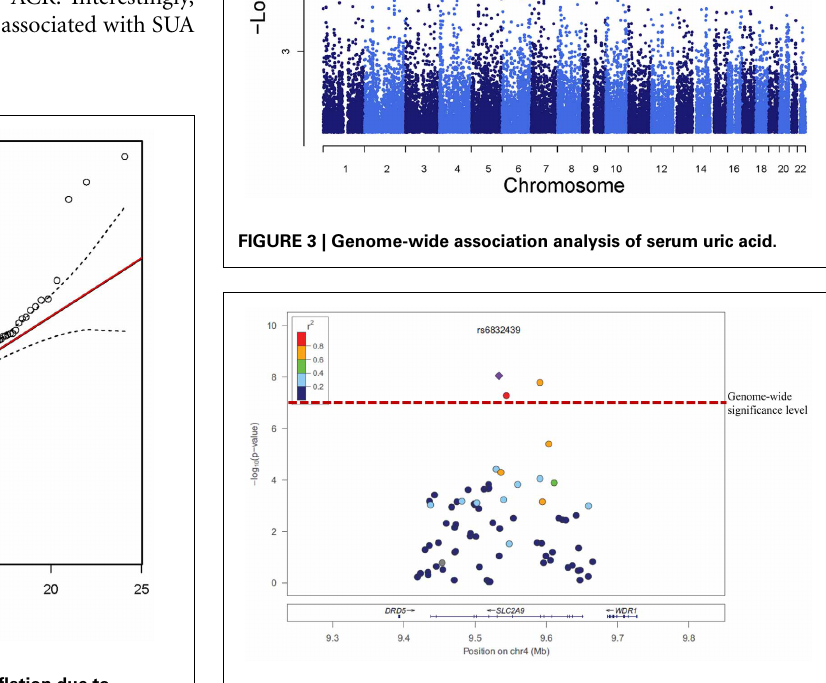
FIGURE 4 | Association of serum uric acid with SLC2A9 SNPs.